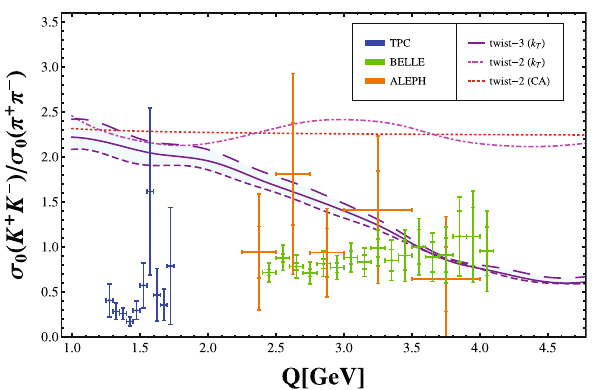
Fig. 6 Cross section ratio σ 0 ( K + K − )/σ 0 (π + π − ) . Red dotted line: thetwist-2resultinthecollinearfactorization;Magentadot-dashedline: thetwist-2resultinthe k T factorization;Purplelines:thetwist-3resultin the k T factorization. The cyan band indicates the theoretical uncertainty arise from the chiral enhancement parameters μ M . The experiment data aretakenfromthecollaborationsofTPC[12],ALEPH[13]andBELLE [15] The cross section ratio σ 0 ( K + K − )/σ 0 (π + π − ) is